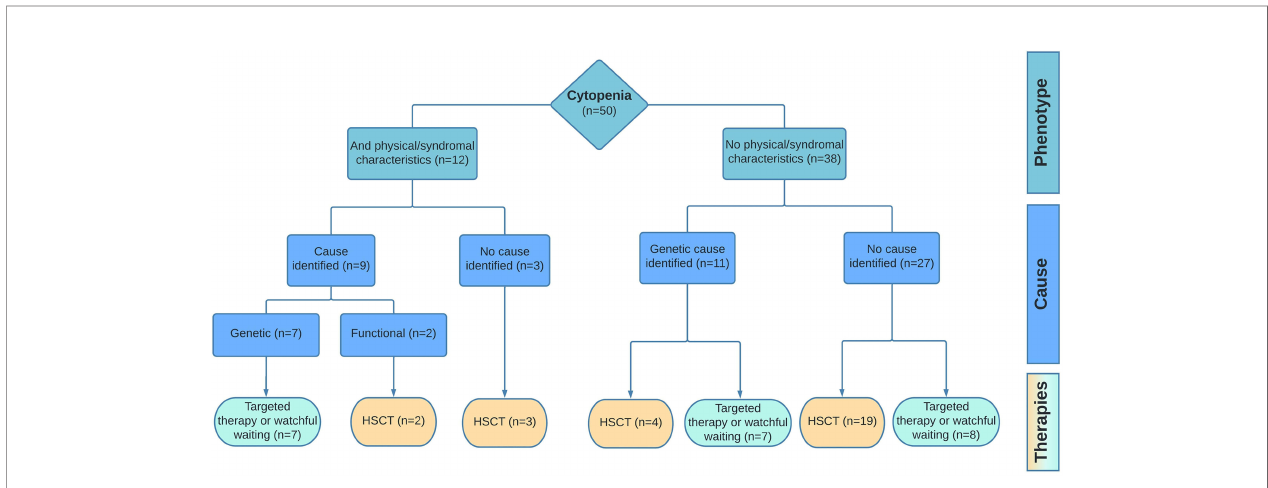
FIGURE 3 | Diagnostic outcome and management. Results of the diagnostic pipeline and the implemented therapies are shown for patients with cytopenia and additional (phenotypic/syndromal) abnormalities vs patient with isolated cytopenia. Targeted therapy includes treatment options as corticosteroids, androgens, or dietary